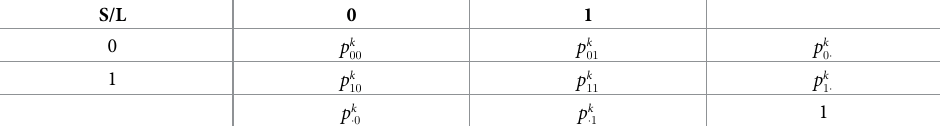
Table 4. 2x2 crosstable of possible short-term (S) and long-term (L) outcomes and their respective probabilities, as well as the marginal probabilities, with respect to treatment (denoted by superscript k ).